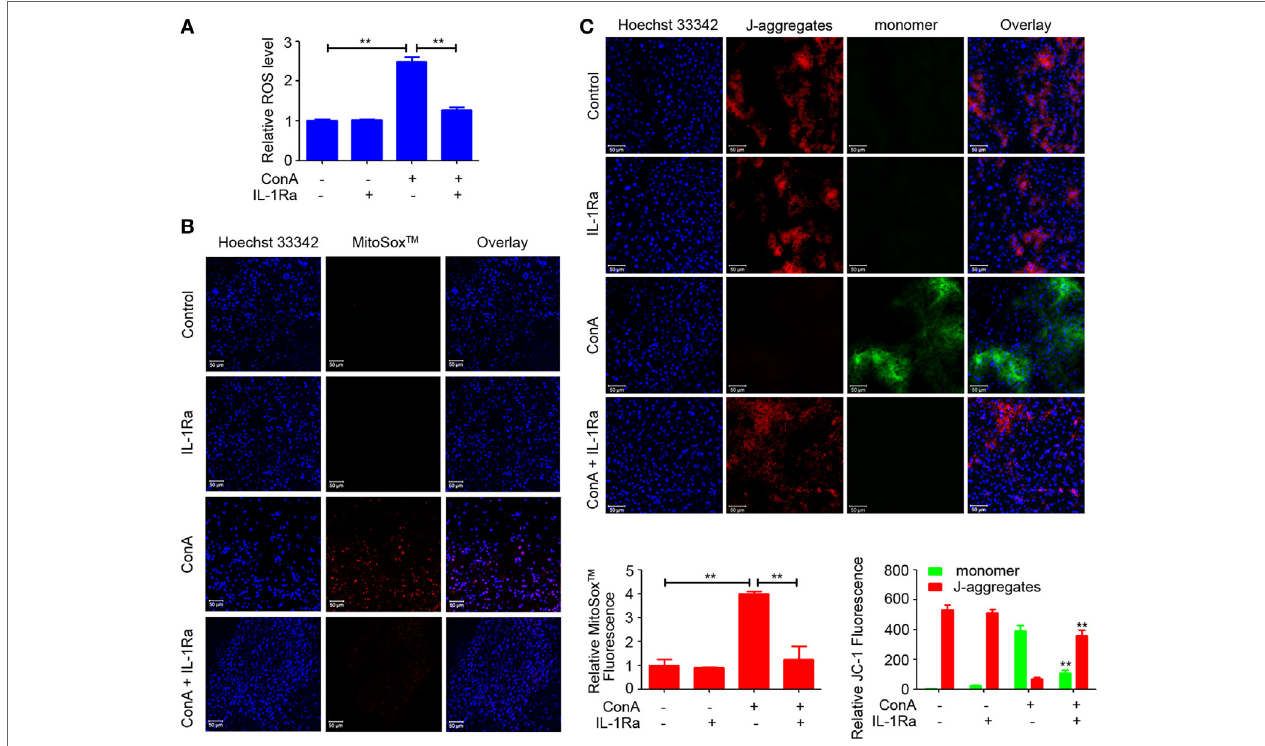
FigUre 6 | Recombinant human interleukin-1 receptor antagonist (RhIL-1Ra) inhibited NOD-like receptor protein 3 inflammasome activation via eliminating reactive oxygen species (ROS). (a) BALB/c mice ( n = 6 for each group) were pretreated with rhIL-1Ra and then intravenously administrated with ConA. 12 h later, samples were collected for following analysis. Intracellular ROS was stained with DCFH-DA (Red) and examined by a fluorescence microplate reader. (B) Representative images from liver tissues staining with MitoSox ™ were obtained by confocal microscopy. MitoSox ™ (Red), Hoechst 33342 (blue), Scale bars = 50 µm. Relative MitoSox ™ fluorescence were quantified. (c) JC-1 probe was used to detect mitochondrial membrane potentials in the livers. Scale bars = 50 µm. Relative JC-1 Fluorescence was quantified and analyzed by Zeiss LSM710-ZEN 2012 Software. The value of JC-1 monomer in control was set to 1. The data were presented as means ± SD (Student’s t -test, * p < 0.05, ** p <